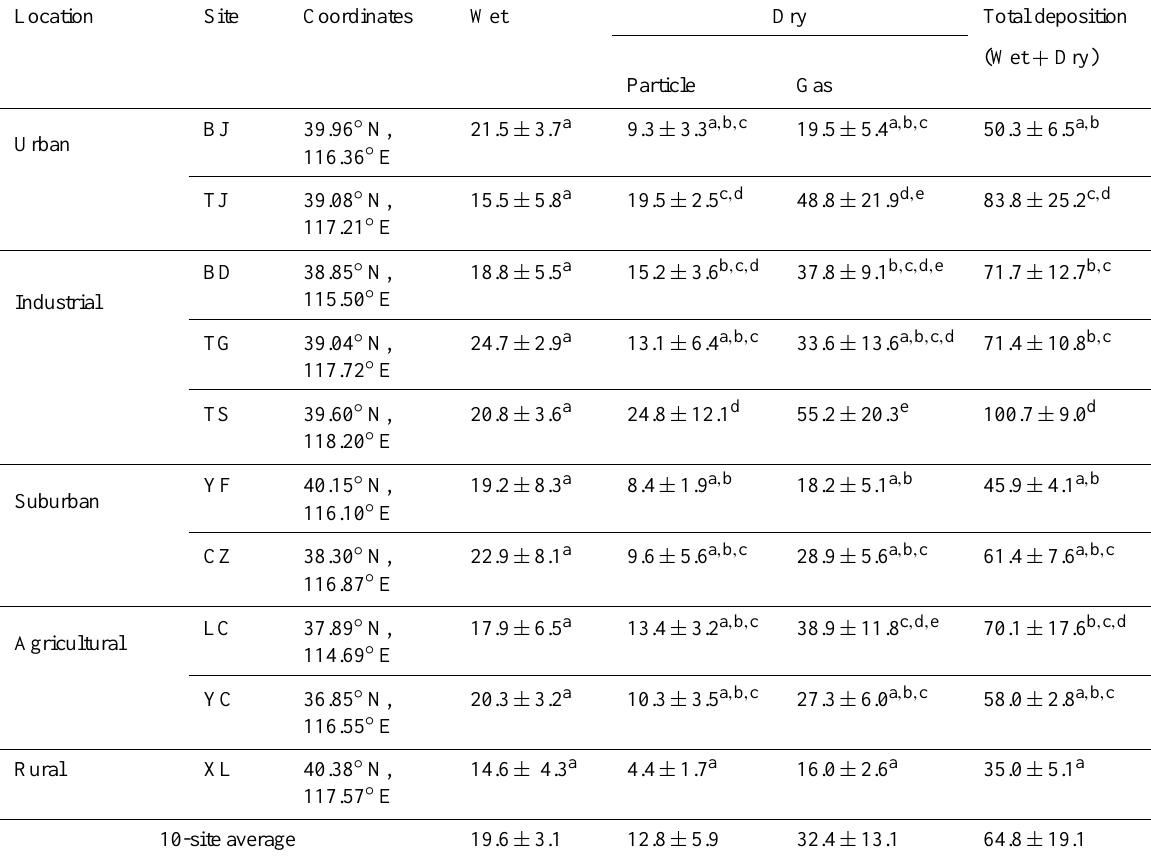
Table 1. Wet and dry deposition flux of sulfur (kg S ha − 1 yr − 1 ) in Northern China.